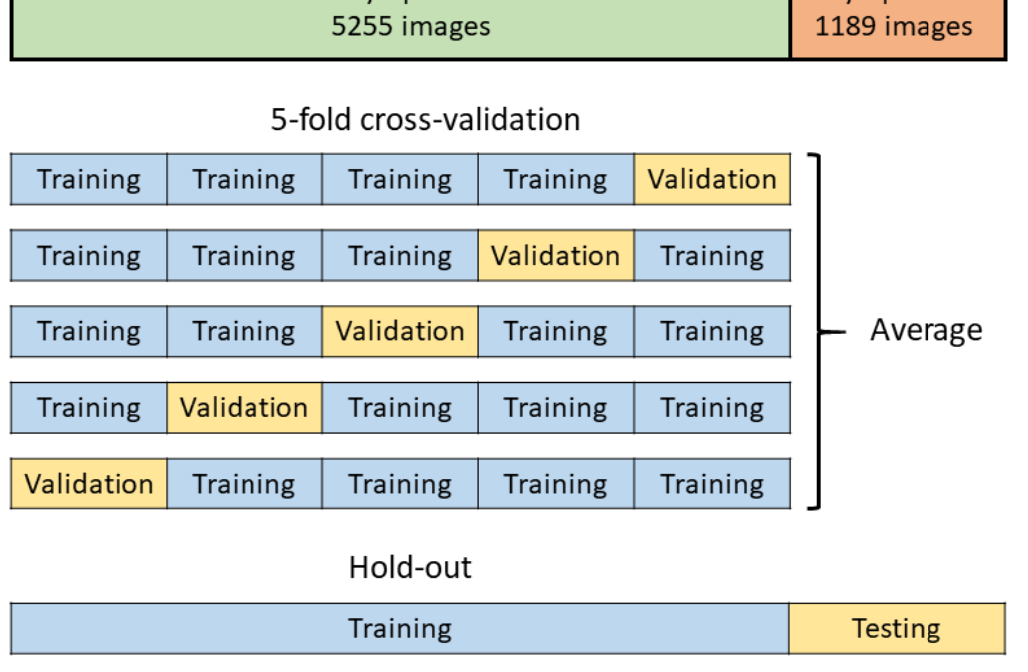
Figure 1. The concept of deep learning algorithm.